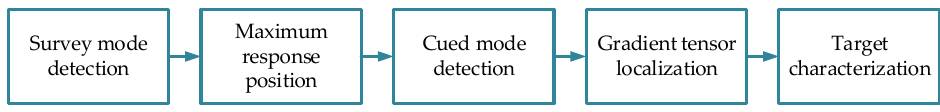
Figure 7. Target detection and data processing.